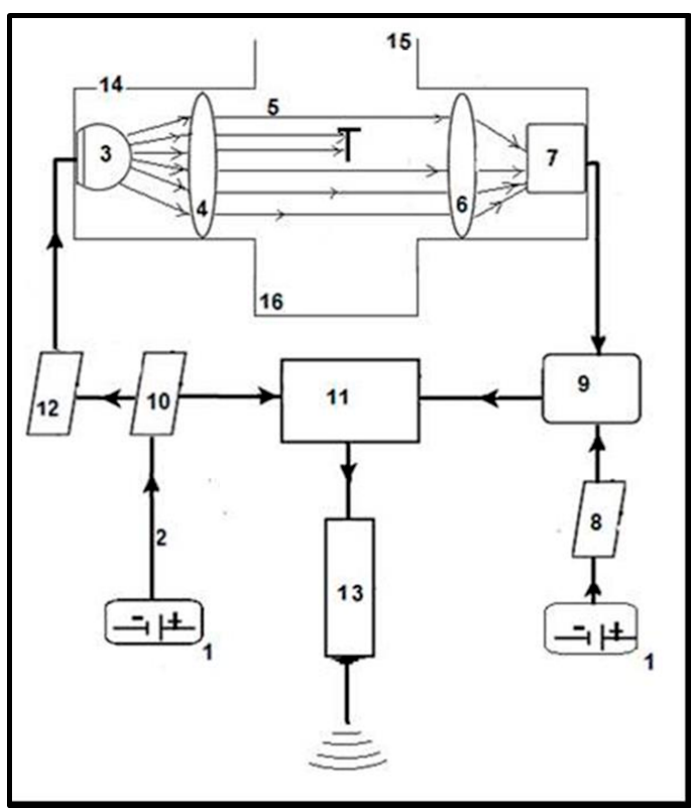
Figure 2. Operational flow chart of detecting and measuring falling-in objects through the dual optical-electronic sensors. The sensor has an electronically controlled light-emitting diode ( 3 ) containing the observation space ( 5 ), fitted to the housing ( 14 ) and a sensor ( 7 ) connected through the signal amplification module ( 9 ) to the electronic control unit ( 11 ). The power supply of the control unit ( 11 ) is supplied from the power source ( 1 ) through the supply circuit ( 10 ) from where, by the insertion of a filter ( 12 ), the power supply of the infrared light-emitting diode ( 3 ) is also provided. The control unit ( 11 ) has a communication module ( 13 ) containing the radio transmitter. The elements of the electronic arrangement are connected to each other via cables ( 2 ). The sensor ( 7 ) is a photodiode in photovoltaic operational mode and it is connected to a power supply unit ( 8 ) and multistage amplifier module ( 9 ). Two plano-convex lenses are placed along the virtual optical axis connecting the light-emitting-diode ( 3 ) and the sensor ( 7 ) passing through the observation space ( 5 ), with an emitter side lens ( 4 ) placed between the light source ( 3 ) and the observation space ( 5 ) at 0.5–1 times of the focal length from the light-emitting-diode ( 3 ), and a receiver side lens ( 6 ) placed between the observation space ( 5 ) and the sensor ( 7 ) at 0.5–1 times the focal length from the sensor ( 7 ). For a particular embodiment, the power sources ( 1 ) are preferably 3 V batteries, the infrared light source ( 3 ) is a TSAL6200 type light-emitting-diode with a wavelength of 940 nm, the casing of the sensor photodiode ( 7 ) has a minimal attenuation for light around 940 nm and the distance between the light-emitting-diode ( 3 ) and the sensor ( 7 ) is 30–60 mm. The optical lenses fitted (using screws enabling fine distance adjustments) to the housing ( 14 ) containing the observation space ( 5 ) and supporting the light source ( 3 ) have diameters of 13 mm, thicknesses at the centre of 3.6 mm and 2.4 mm at the edge with focal lengths of 20 mm. The distance between the lenses is preferably 25–40 mm, and the distance between the sensor ( 7 ) side and receiver ( 6 ) side lenses is about 0.5–1 times the focal length. If the light source ( 7 ) was infrared laser, the emitter side lens ( 6 ) would not be necessary, but the cost of the laser and the energy demand of the operation and the cost of the control elements would also be higher. ( 15 ) Entry point of microarthropods into the sensor and observation space. ( 16 ) Exit point of microarthropods from the sensor.